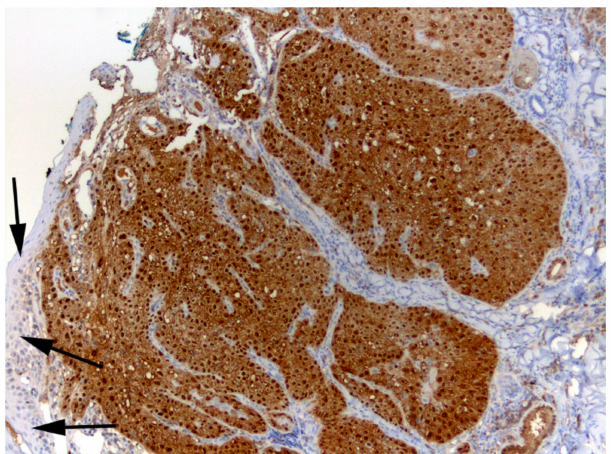
Figure 4. Photomicrograph of a nasal planum squamous cell carcinoma that contained FcaPV6 DNA. This biopsy was obtained 20 months prior to the SCC recurrence shown in Figure 1. Intense nuclear and cytoplasmic immunostaining using anti-p16 CDKN2A protein (p16) antibodies is visible di ff usely within the neoplastic cells. There is minimal immunostaining within adjacent non-neoplastic epidermis (arrows). Hematoxylin counterstain.